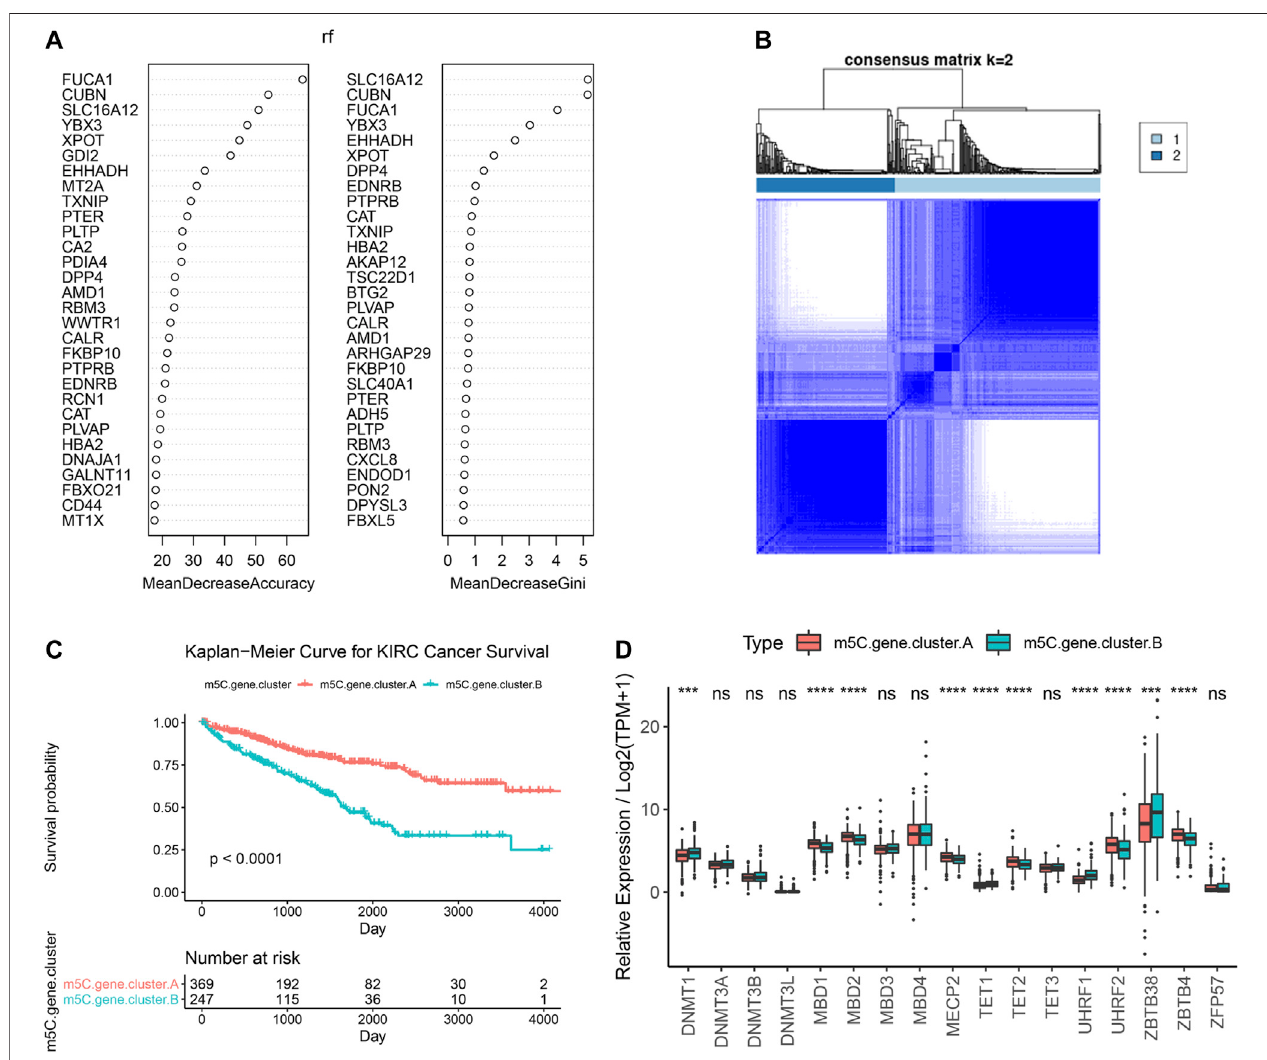
FIGURE 4 | Identi fi cation and prognostic implications of m 5 C genotype signatures. (A) Random forest results for selecting the most important DEGs. (B) Unsupervised clustering based on the expression of selected DEGs. (C) Overall survival curves of ccRCC cases in the indicated subgroups. (D) Expression levels of 17 m 5 C regulators in the indicated